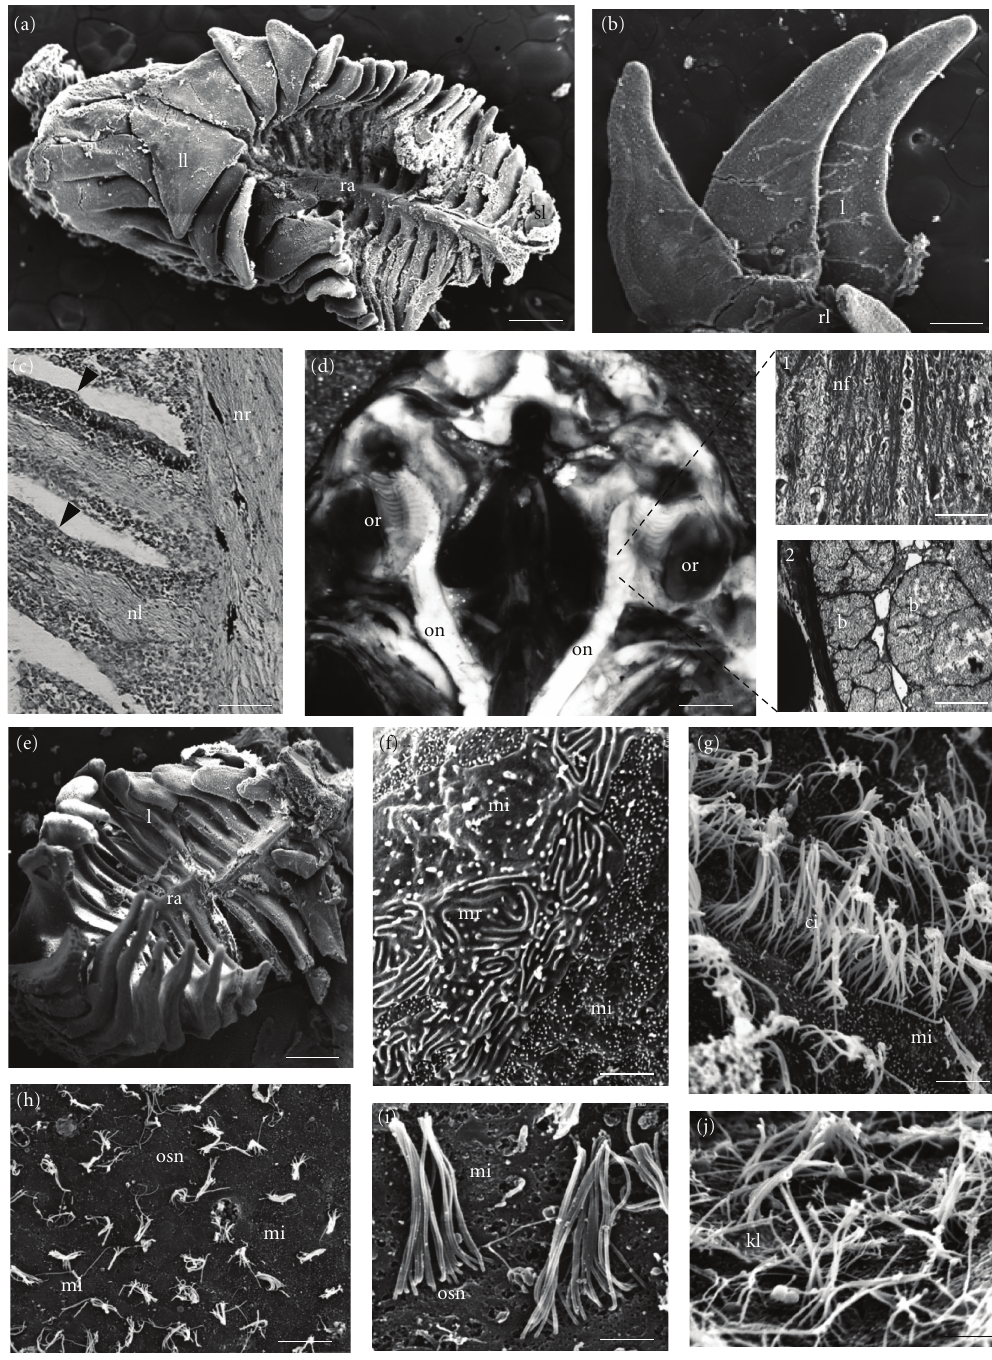
Figure 2: Olfactory rosettes and their lamellae with olfactory neurons. (a) The olfactory rosette of Saurida macrolepis, scale bar = 0.8 mm; (b) lateral aspect of isolated lamellae of Synodus variegatus, scale bar = 100 μ m; (c) longitudinal section of lamellae of S. gracilis , featuring olfactory fibers and nerve in the raphe, scale bar = 60 μ m; (d) exposed brain, olfactory nerves and rosettes of S. tumbil , scale bar = 2.4 mm ( inset 1 , longitudinal section of the ON; inset 2 , cross section of the same; scale bars = 100 μ m, LM); (e) olfactory rosette of S. gracilis, scale bar = 1 mm ; (f) the rim of an olfactory lamella of Sy. variegatus , scale bar = 8 μ m; (g) rows of ciliated cells on lamellae of the same, scale bar = 4 μ m. (h) mosaic of ORN on a lamellae of S . tumbil , scale bar = 12 μ m; (i) isolated ORN of Trachinocephalus myops, scale bar = 2.6 μ m; (j) Kinocilia-cells at the base of olfactory lamellae of S. macrolepis , scale bar = 4 μ m. b, boundless of neural filaments; c, cilia of ORN; kl, kinocilia; l,olfactory lamellae; ll, largest lamella; mi, microvillar cells; mr, microridges on cell surfaces; nf, neural fibrille; nl, nerve-bundles in olfactory lamellae; nr, nerve branch in the raphe; on, olfactory nerve; or, olfactory rosettes; osn, cilia of olfactory sensory neurons; sl, smallest lamellae; ra, raphe of rosette; triangles, sensory epithelium (C and insets, LM; all other